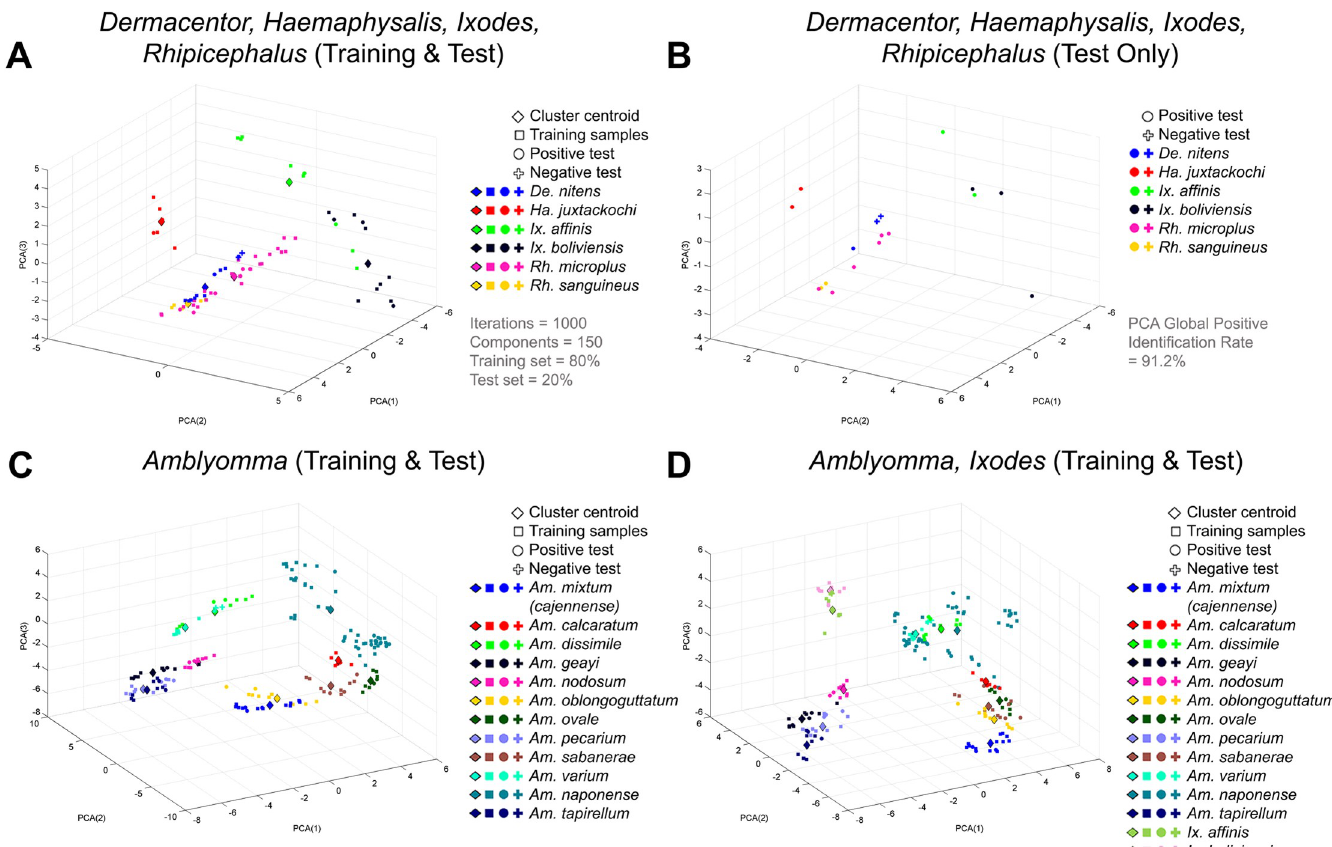
Fig 3. Principal component analysis (PCA) of individual species plotted against first, second and third principal components (PC). All species were classified using a Monte Carlo simulation with 1000 iterations, in which 80% of the samples were used as training set ( □ ) and the remaining 20% as test set (• for positive identifications and + for negative ones). The cluster centroid of each species is also presented in the graph ( � ). The plots show (A) the training and test sets for the species belonging to the Dermacentor , Haemaphysalis , Ixodes and Rhipicephalus genera, and (B) only the test sets for better visualization; as well as the training set and test set of (C) Amblyomma species alone or (D) Amblyomma in combination with Ixodes genera. The unsupervised PCA algorithm had a global positive identification rate of 91.2%. These 3D plots represent only one of the 1000 Monte Carlo iterations performed with the